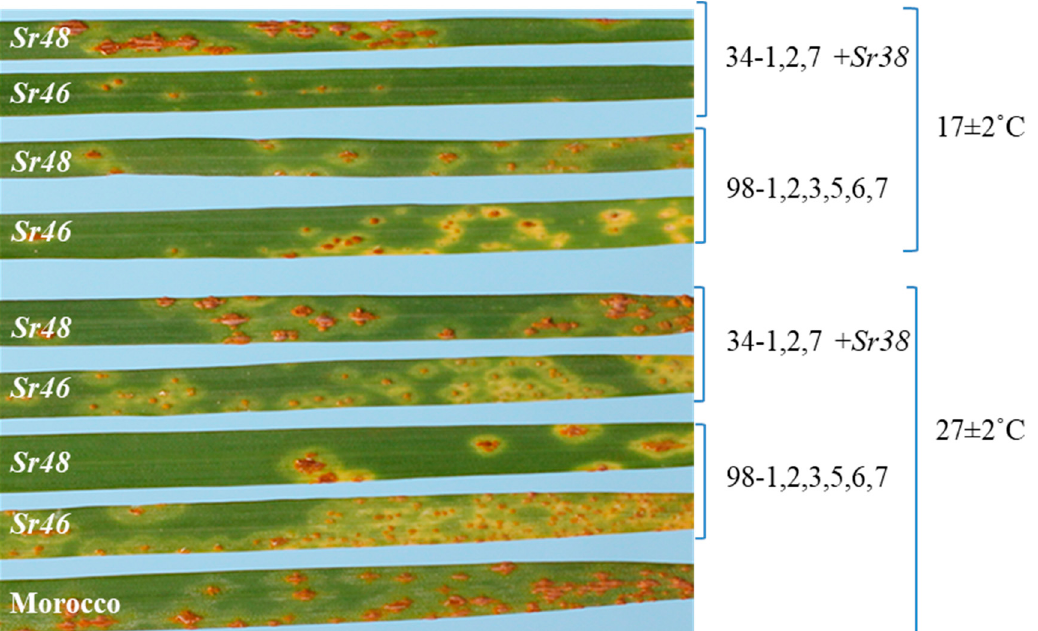
Figure 5. Seedling responses of genotypes carrying Sr48 (Arina), Sr46 (hexaploid derivative of Aus18913 progeny number 7.1a) and Morocco (the susceptible check) against Pgt pathotypes 34-1,2,7+Sr38 and 98-1,2,3,5,6,7 when tested at two temperature regimes in the greenhouse.